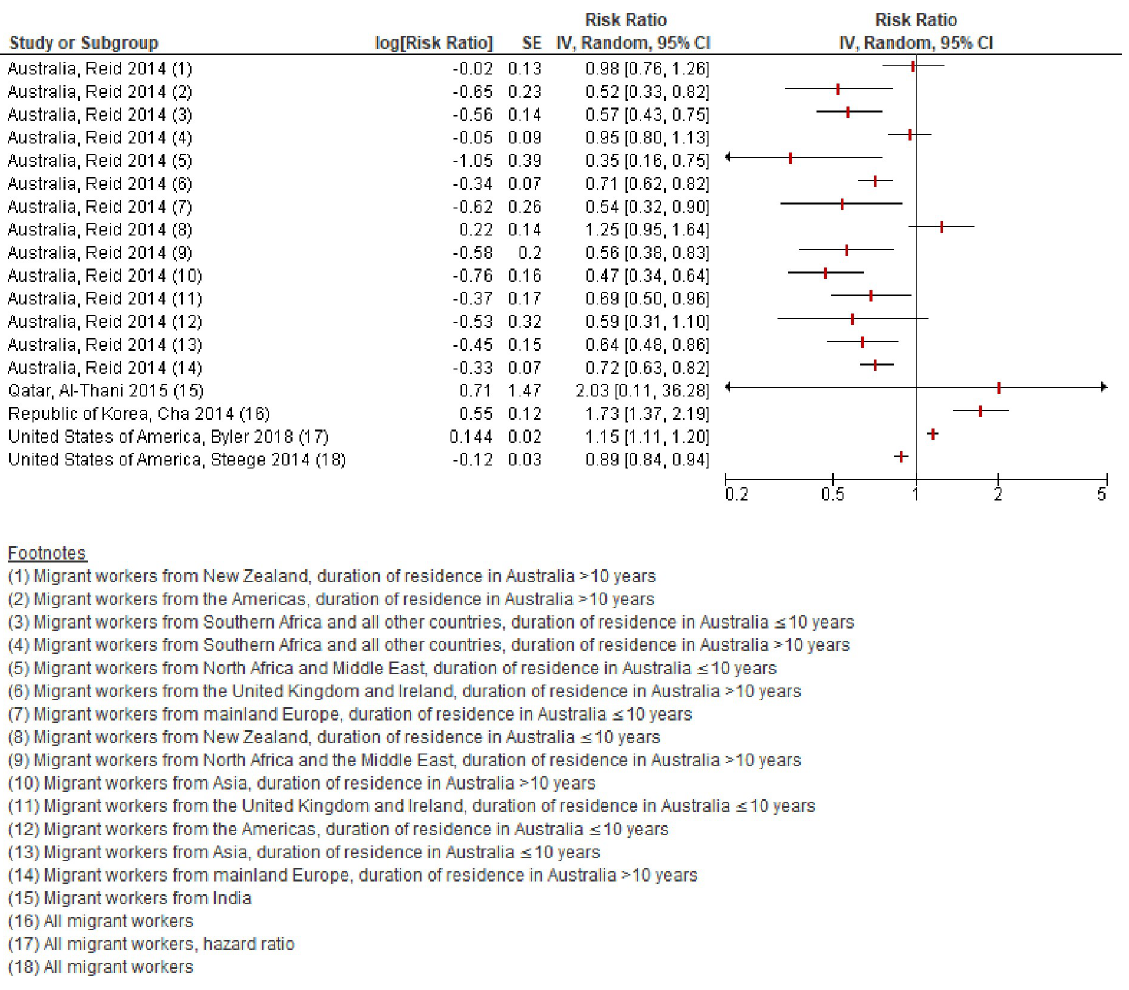
Fig 3. Has died of an occupational injury, migrant workers compared with non-migrant workers,